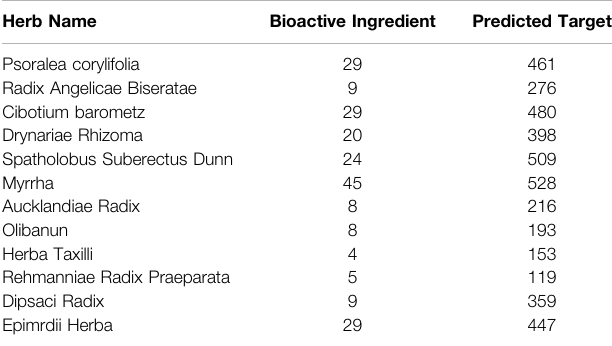
TABLE 1 | Statistical table for basic information of traditional Chinese medicine- composition-target in